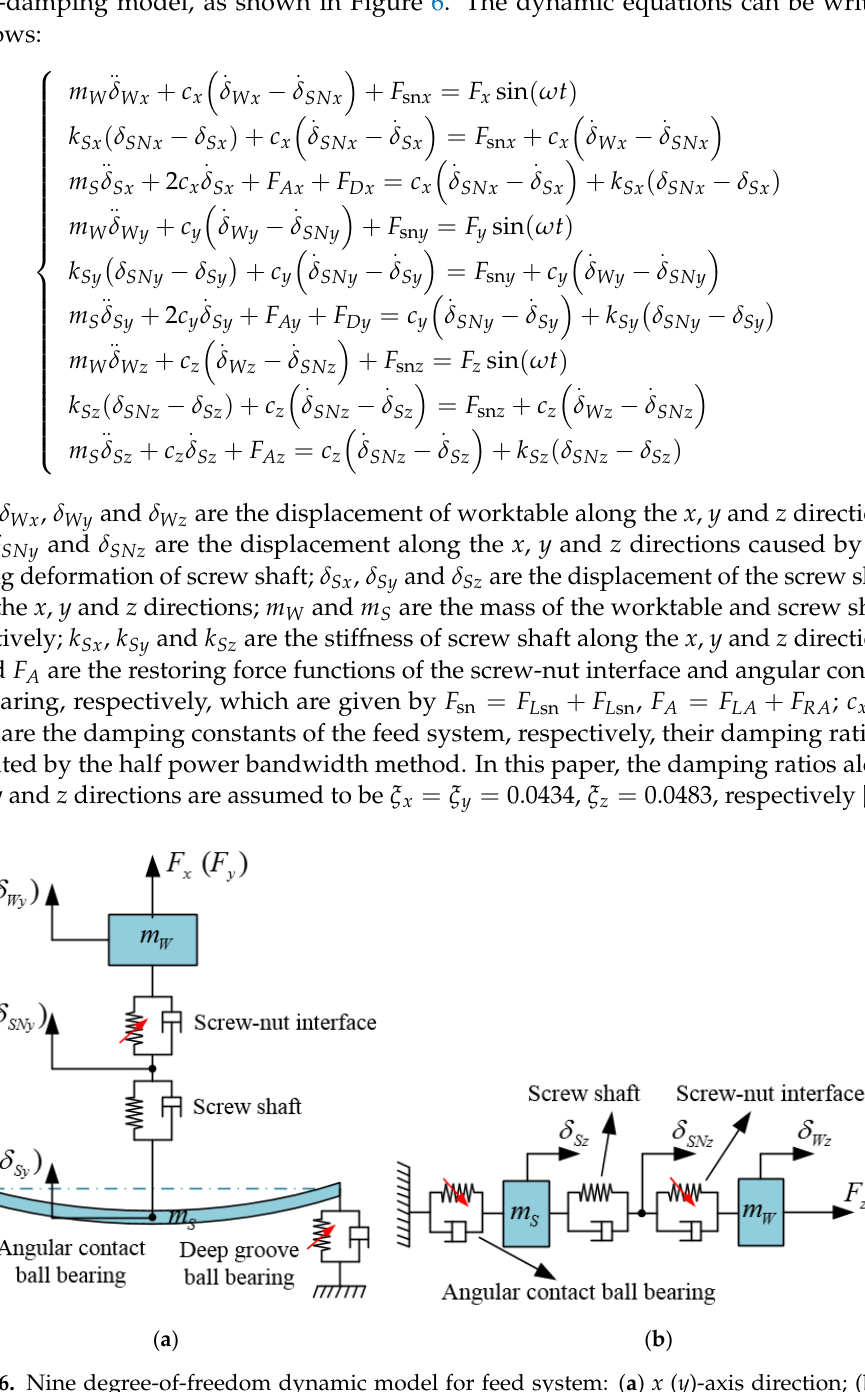
Table 1. Specifications of ball screw.